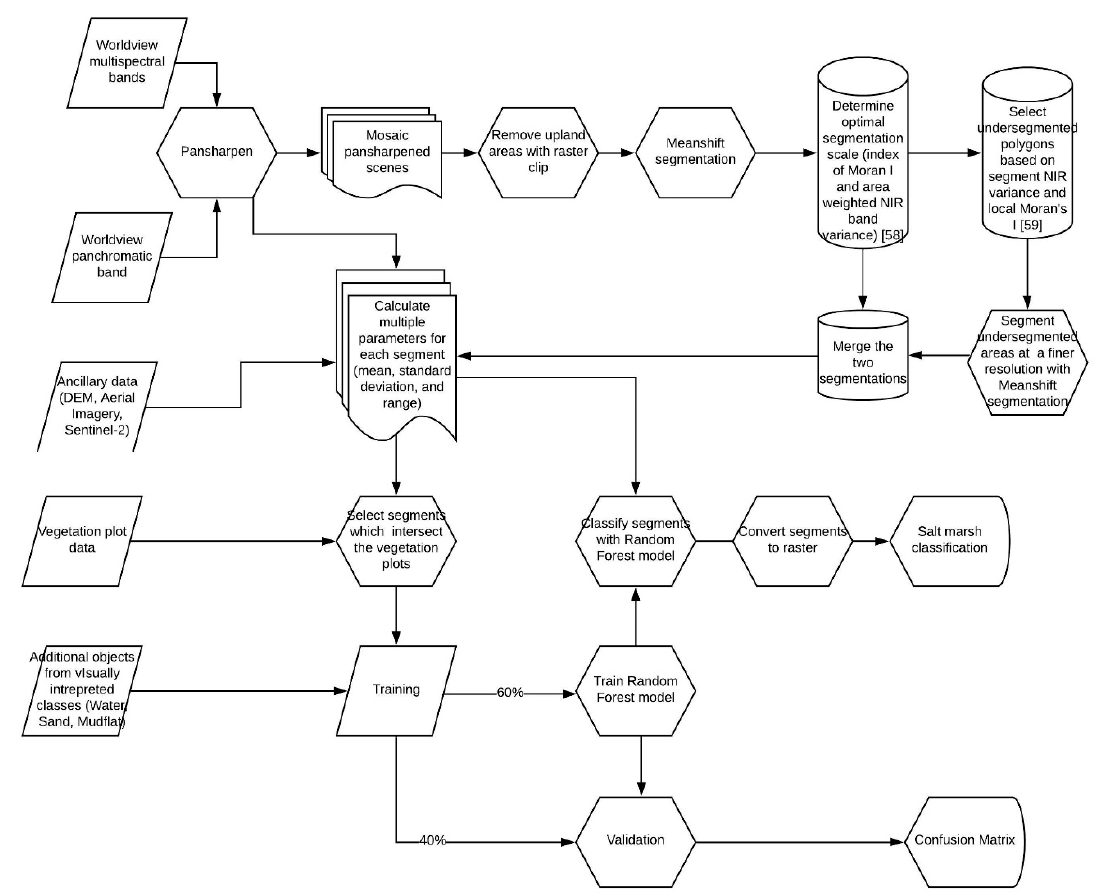
Figure 2. The data processing and classification workflow for classification of the Worldview-2 and Worldview-3 imagery.